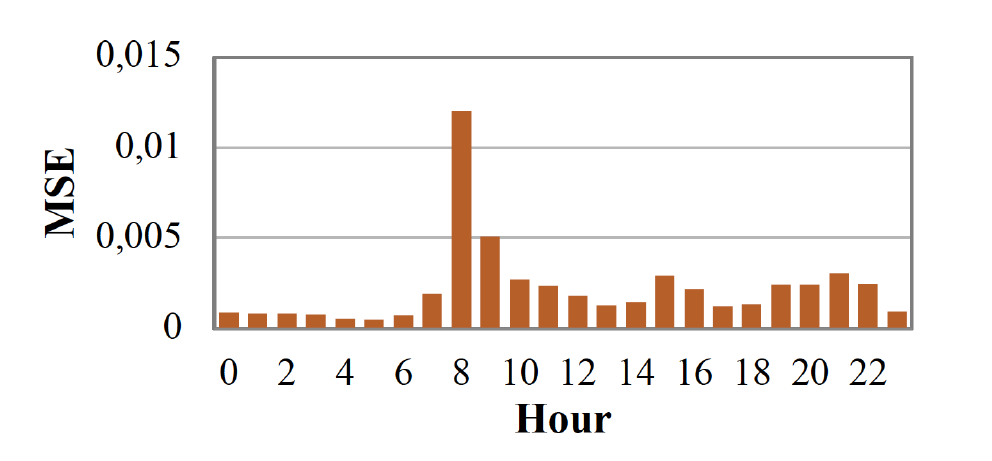
Figure 8. Distribution of errors according to the day hour in one of the